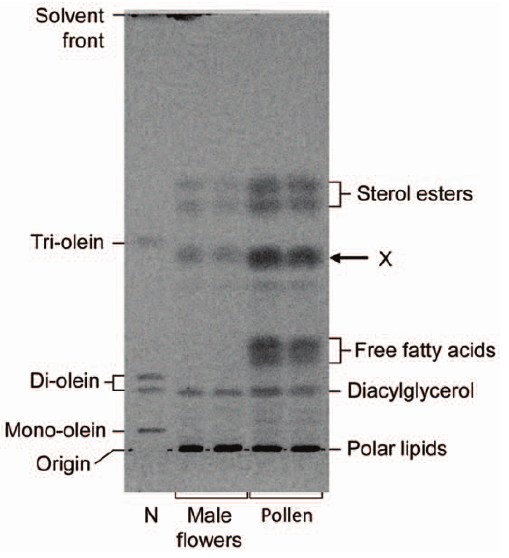
Figure 3. TLC analysis of neutral lipids from castor developing male flowers and pollen. Lipid extracts were applied to a silica TLC plate which was developed with hexane/diethyl ether/acetic acid (70:30:1) before iodine-staining. The position of lipid standard components (lane N) and proposed nature of resolved sample lipids are shown. Lipid X and proposed sterol esters were purified for further analysis. doi:10.1371/journal.pone.0030100.g003 PLoS ONE |